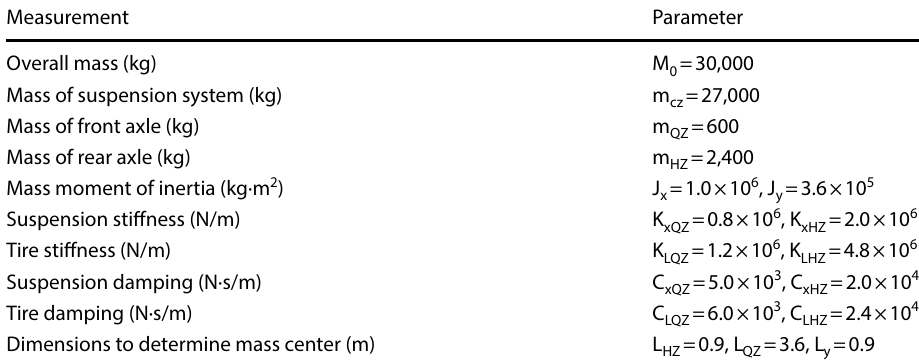
Table 3 Parameters of the test vehicle model